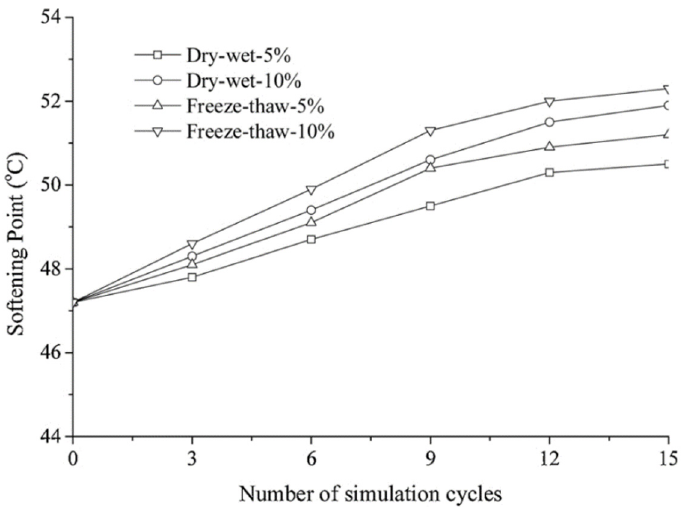
Figure 1. The result of the bending beam rheometer test: the dependence of the modulus of hard- ness of the Zhenhai#70 asphalt on the number of drying—wetting and freezing—thawing cycles. Reprinted with permission from [8].